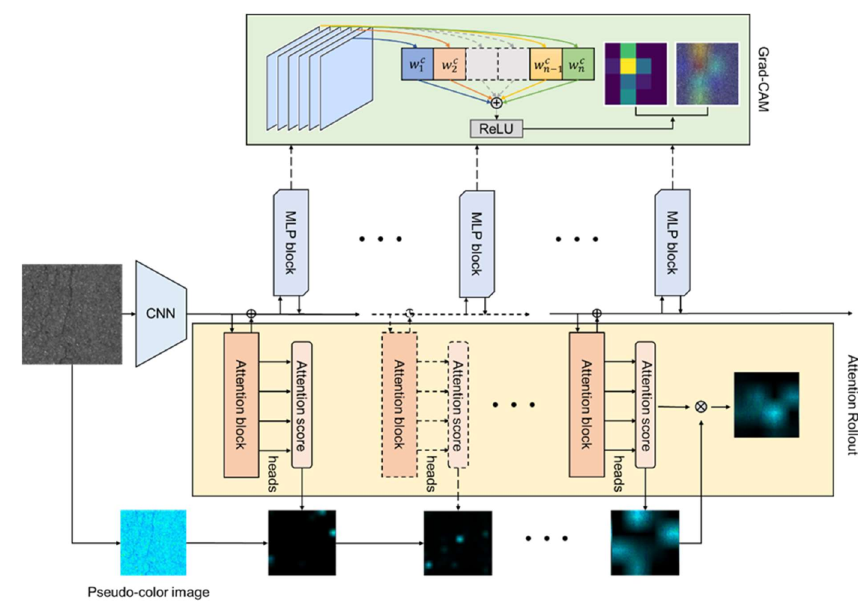
Figure 9. Visual interpretation methods used in this